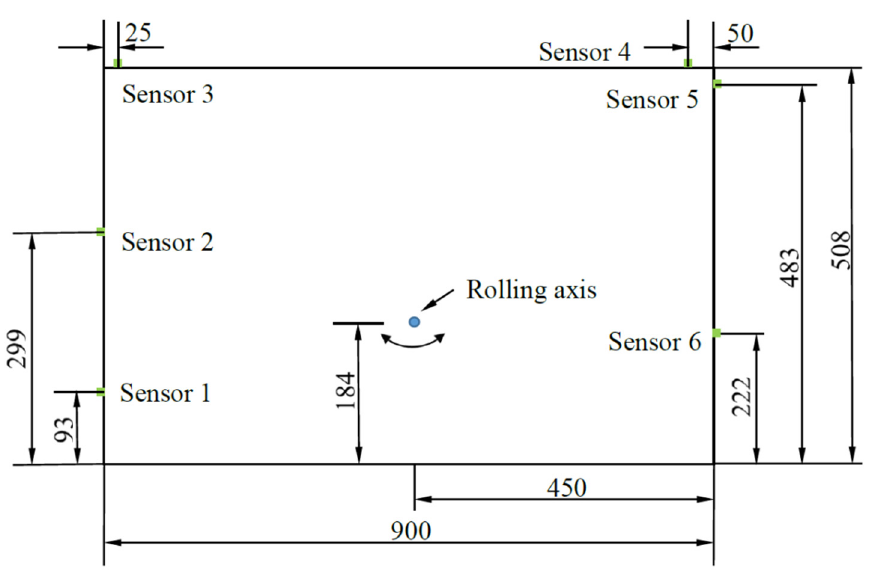
Figure 2. Tank geometry and position of the sensors (in millimeters).